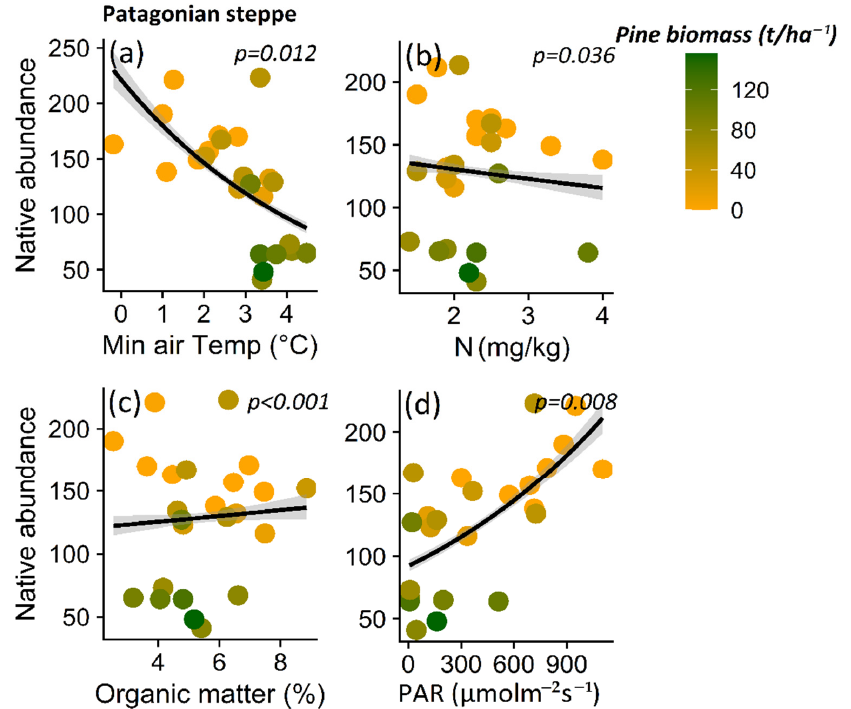
Figure 8. Relationship between native plant total abundance and minimum air temperature ( a ), nitrate content ( b ), organic matter ( c ), and PAR light ( d ) for the Patagonian steppe. The lines show the linear model fit and the 95% confidence interval and the color gradient at the points corresponds to the biomass gradient of Pinus contorta for the Patagonian steppe.